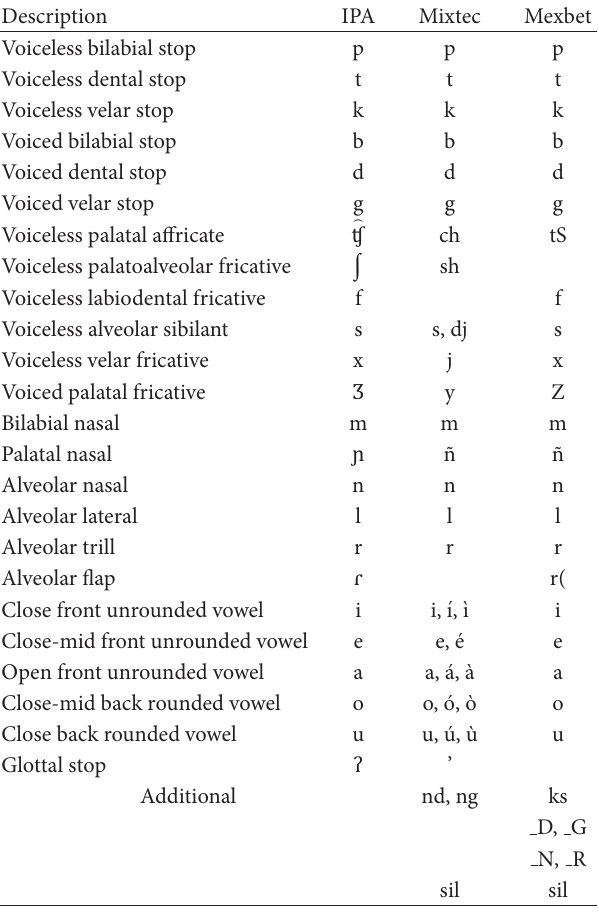
Table 2: Repertoire of Mixtec